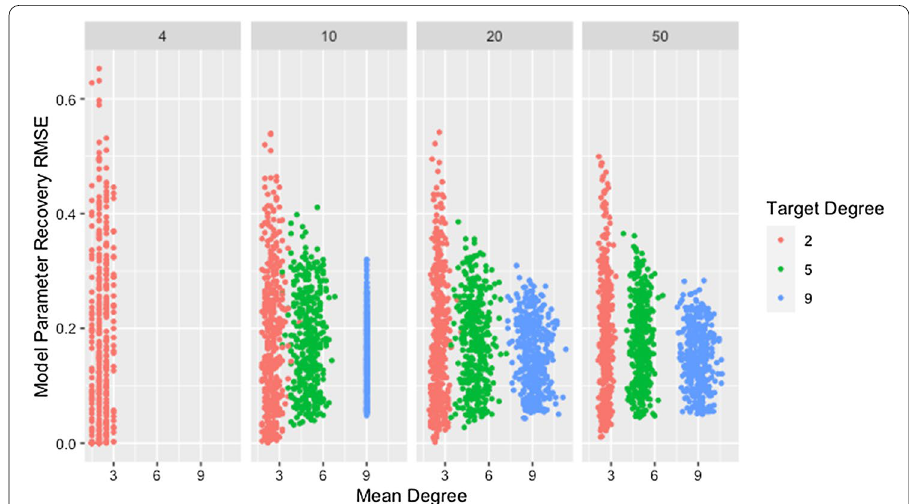
Fig. 1 RMSE for model parameter recovery by degree and size. RMSE for known and predicted weights by mean degree, target degree, and network size across